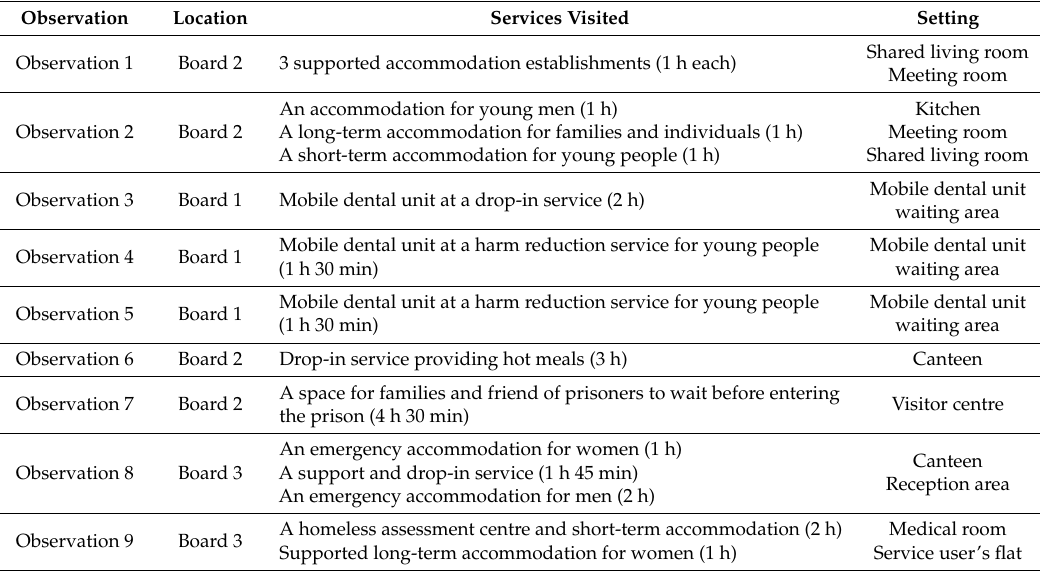
Table 1. Details of observation sessions.